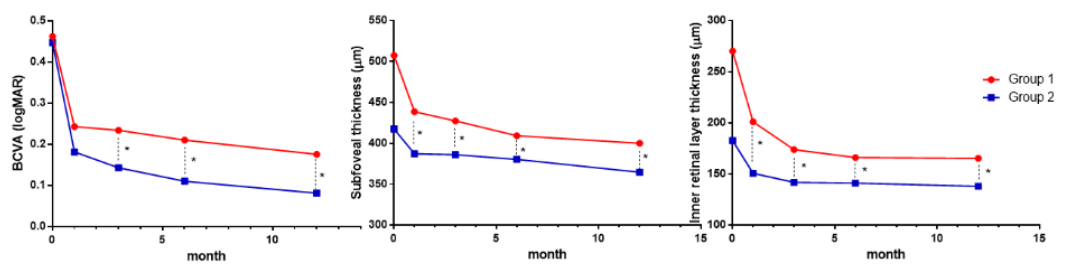
Figure 2. Best-corrected visual acuity (BCVA), subfoveal thickness, and inner retinal layer thickness at baseline (preoperative), 1, 3, 6, and 12 months postoperatively in epiretinal membrane patients with ILM dehiscence (group 1) and patients without ILM dehiscence (group 2). * p < 0.05. The BCVA at 6 and 12 months after surgery were also significantly di ff erent between the two groups. The SFTs were 507.4 ± 80.0 and 417.6 ± 63.6 µ m in groups 1 and 2, and the IRLTs were 270.2 ± 74.3 and 182.6 ± 60.4 µ m, respectively (both p < 0.001). These di ff erences between the groups remained throughout the follow-up period (at 1, 3, 6, and 12 months). The changes in the BCVA, SFT, and IRLT from baseline to 12 months after surgery were significantly di ff erent between the groups: 0.29 vs. 0.37 ( p = 0.044), 107.3 vs. 52.9 ( p < 0.001), and 104.9 vs. 44.5 ( p < 0.001), respectively (Figure 3). 165 J. Clin. Med. 2020 , 9 , x FOR PEER REVIEW